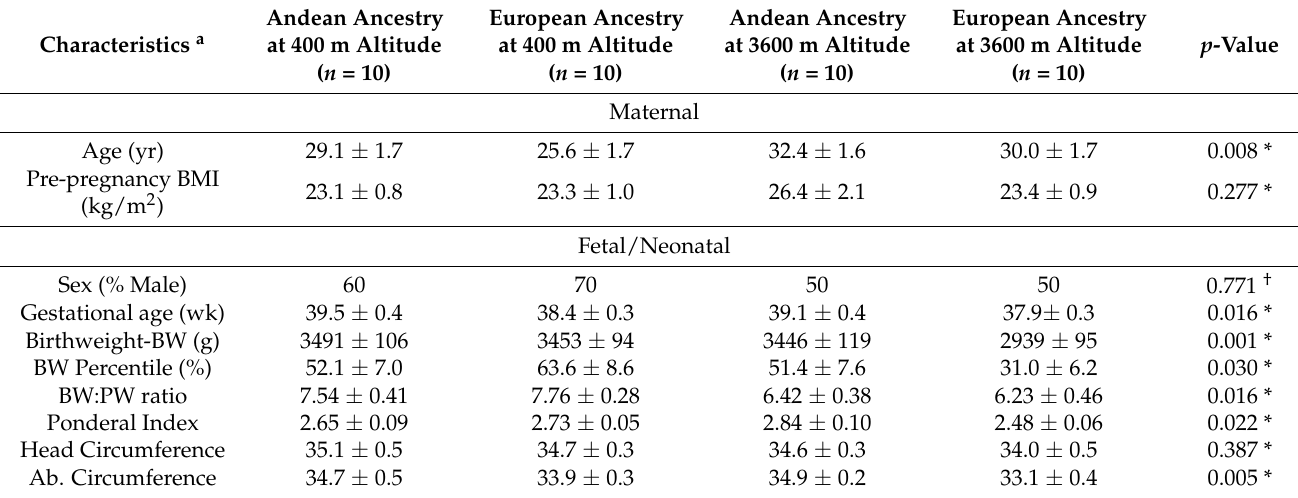
Table 1. Maternal and Fetal/Neonatal Characteristics of the Study